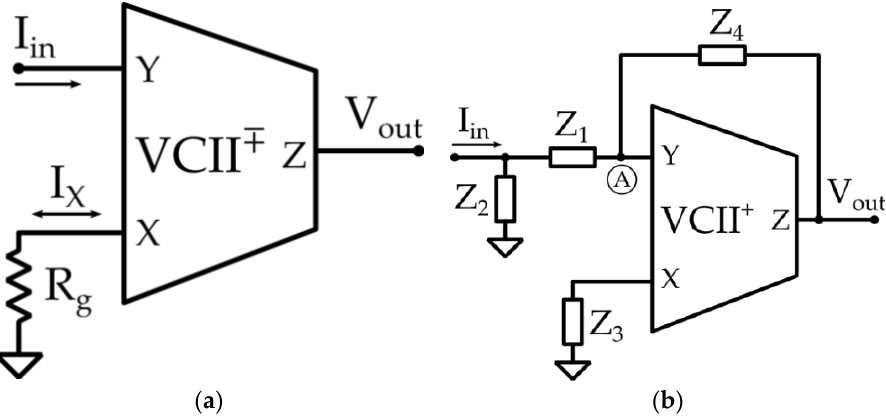
Figure 5. ( a ) VCII-based transimpedance amplifier, and ( b ) VCII-based reconfigurable second-order low-pass and bandpass filter.